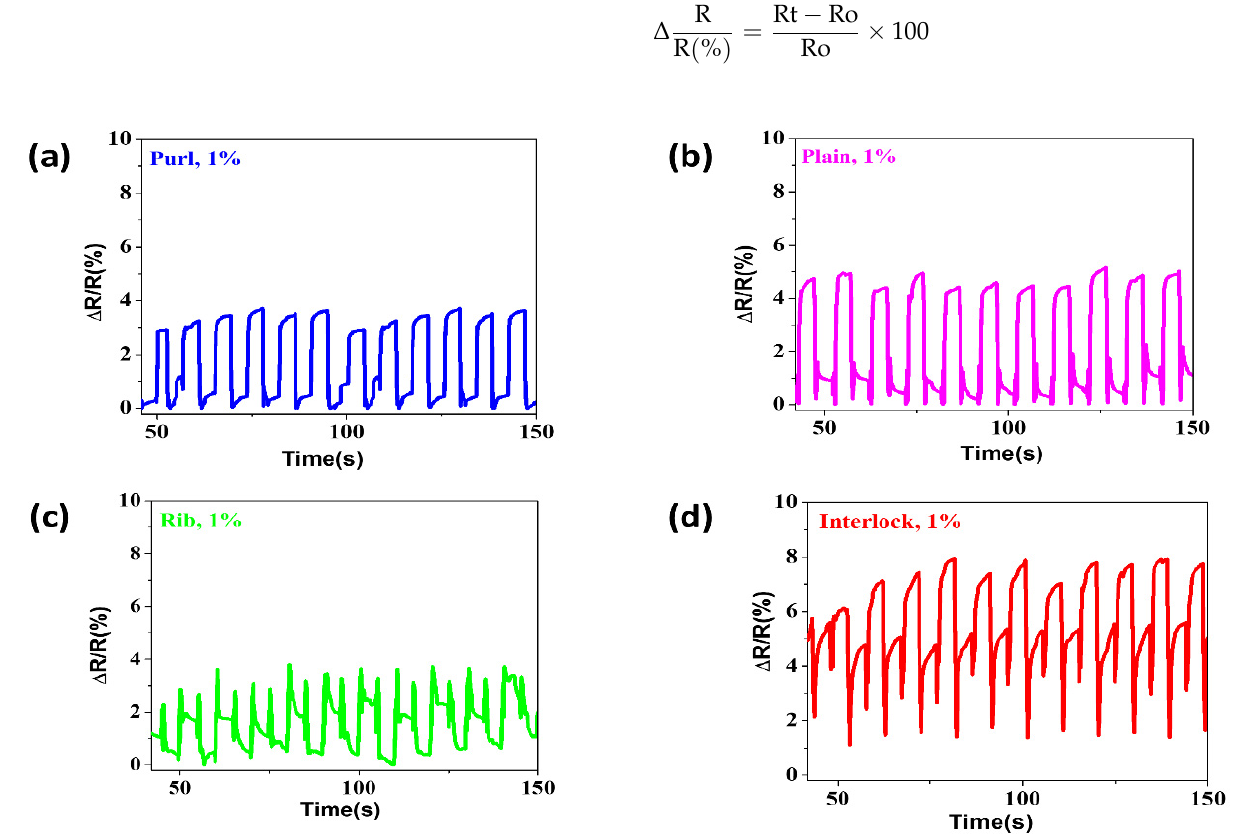
Figure 3. Strain response at 1% of elongation ( a ) purl, ( b ) plain, ( c ) rib, and ( d ) interlock structures.